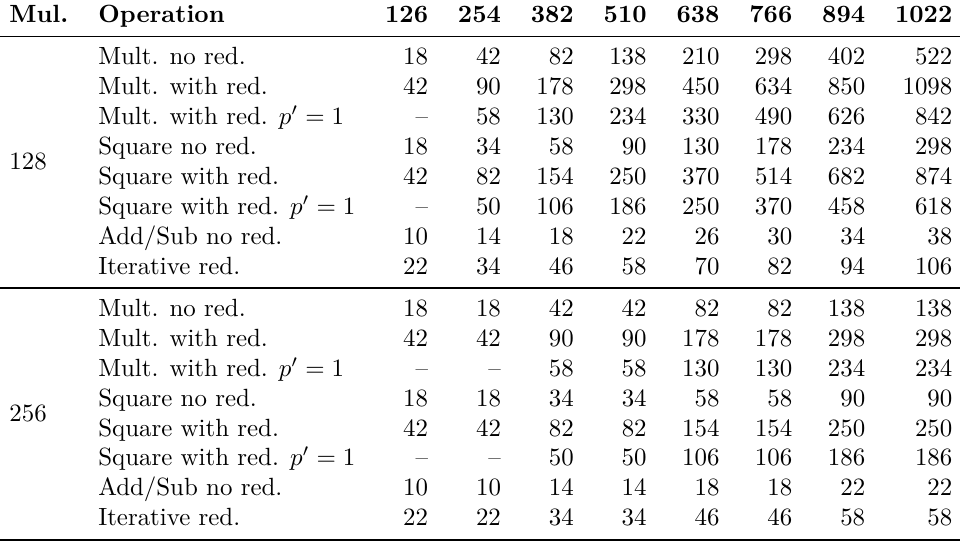
Table 3: Cycle counts of F p operations for the Carmela128 and Carmela256 -based archi- tectures. The top column shows the maximum bit size of the operands. The operations that use the multiplier: multiplication (Mult.) and squaring (Square) with/without modular reduction (red.) perform 8 operations in parallel. The cycles are measured after all 8 outputs have been written to memory. The addition/subtraction (Add/Sub) and iterative reduction only operate on 4 inputs. Mul. Operation 126 254 Mult. no red. Mult. with red. Mult. with red. p 0 = 1 – Square no red. 128 Square with red. Square with red. p 0 = 1 – Add/Sub no red. Iterative red. Mult. no red. Mult. with red. Mult. with red. p 0 = 1 – 234 Square no red. 256 Square with red. Square with red. p 0 = 1 – – 186 Add/Sub no red. Iterative